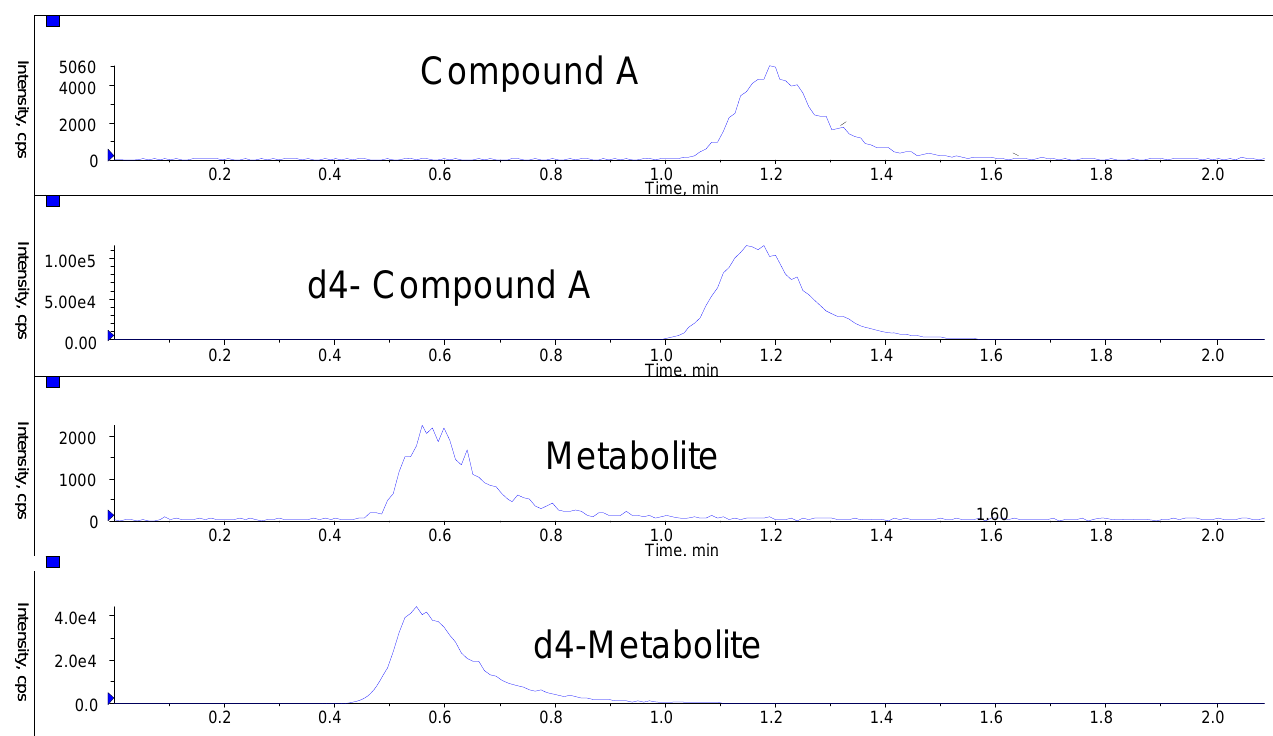
Figure 1. Representative ion chromatograms of an LLOQ sample from the rat whole blood method.